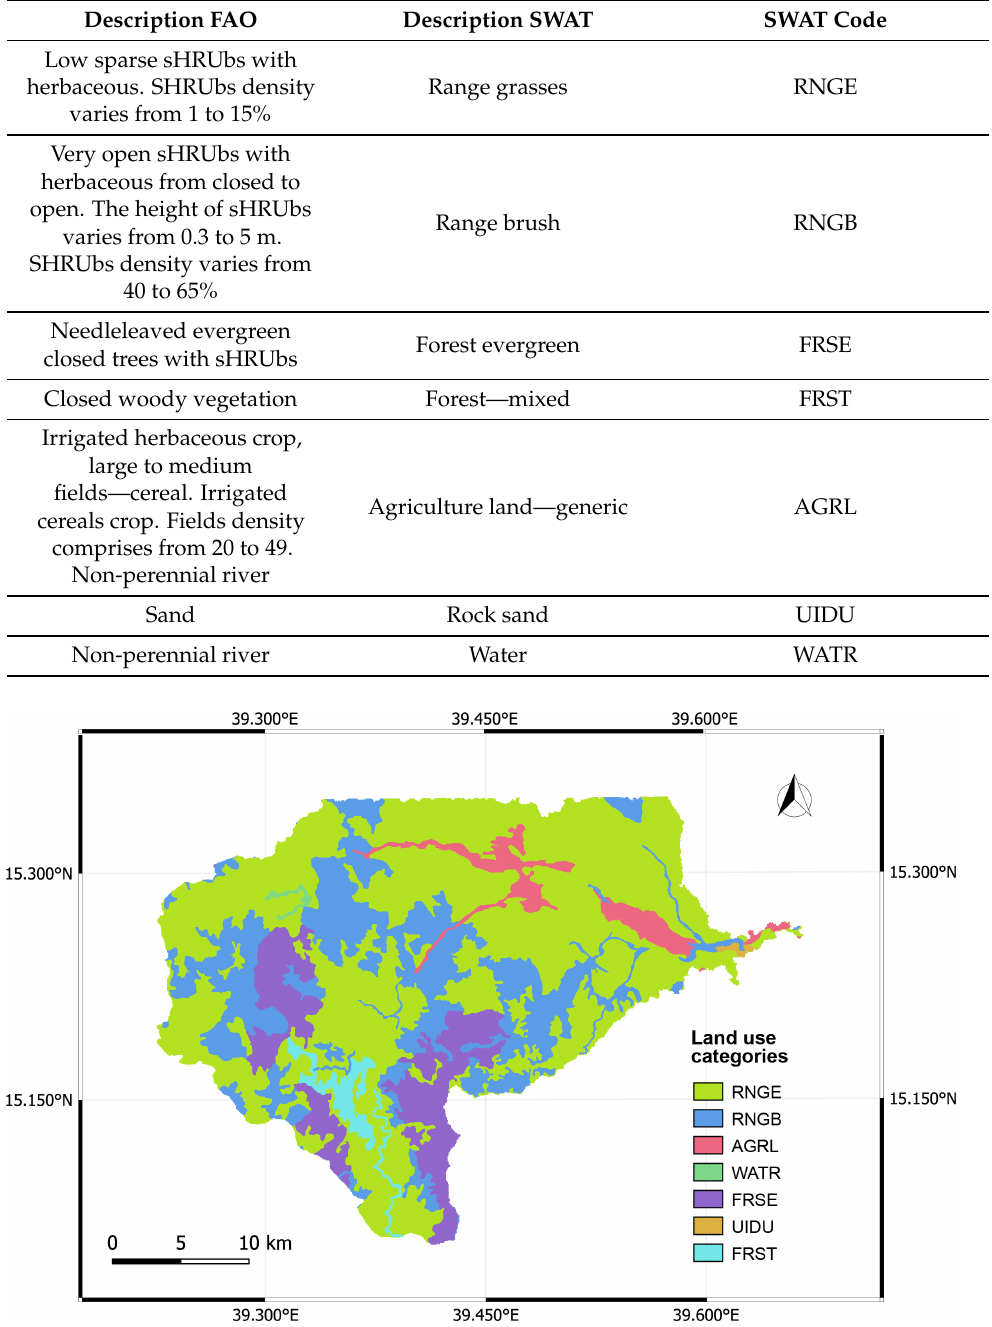
Table 2. Correspondence between FAO and SWAT land use categories.